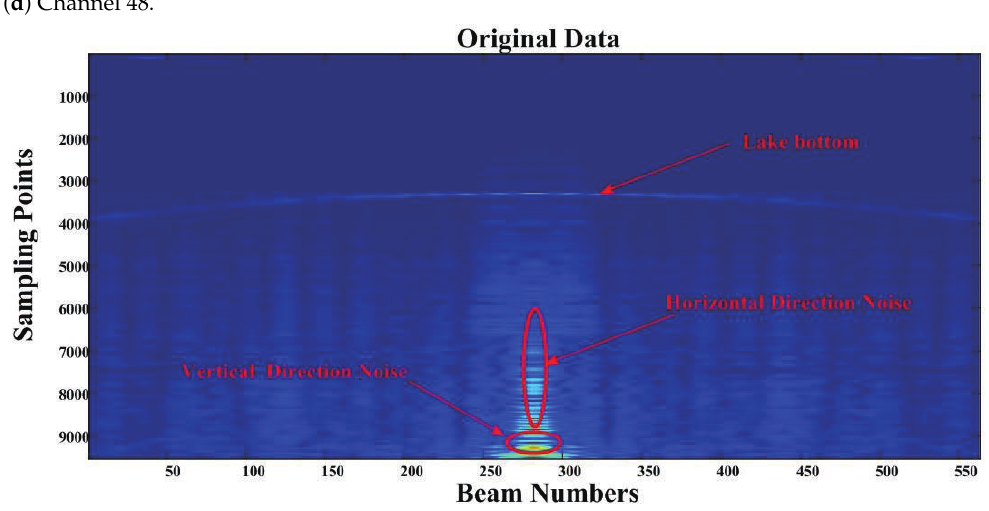
Figure 9. The raw data after